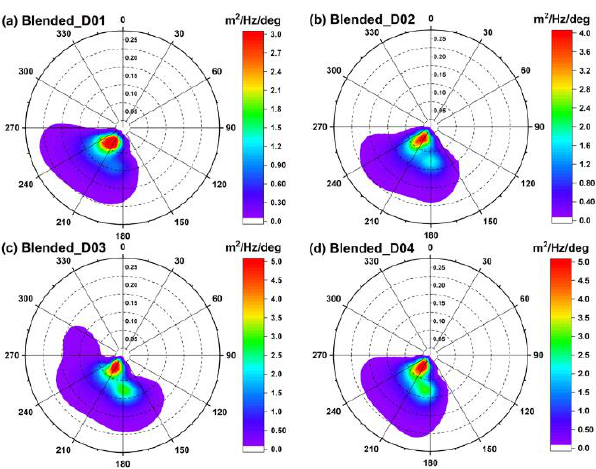
Figure 25. Comparison of the directional wave spectra at the Hualien wave buoy at 00:00 on 27 September 2016, using the four computational domains ( a – d ) and blended wind fields.